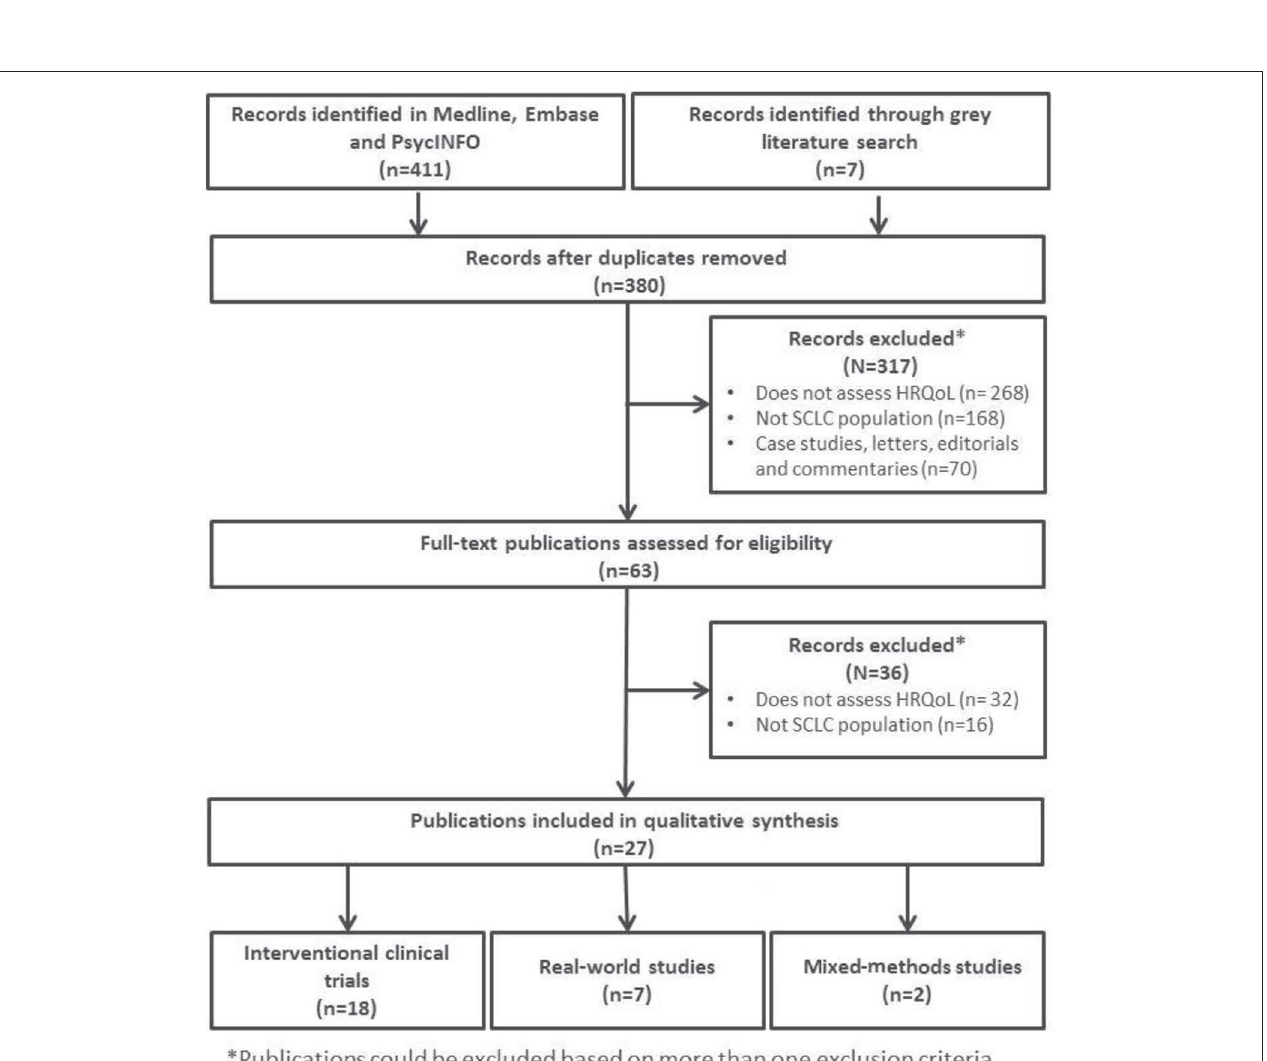
FIGURE 1 | PRISMA flow chart of included and excluded